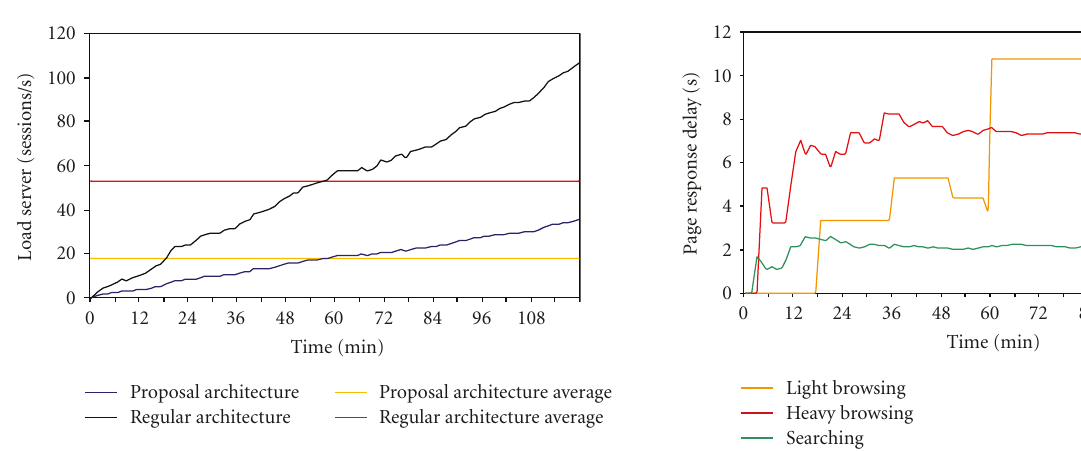
Figure 13: Load on the Web server.